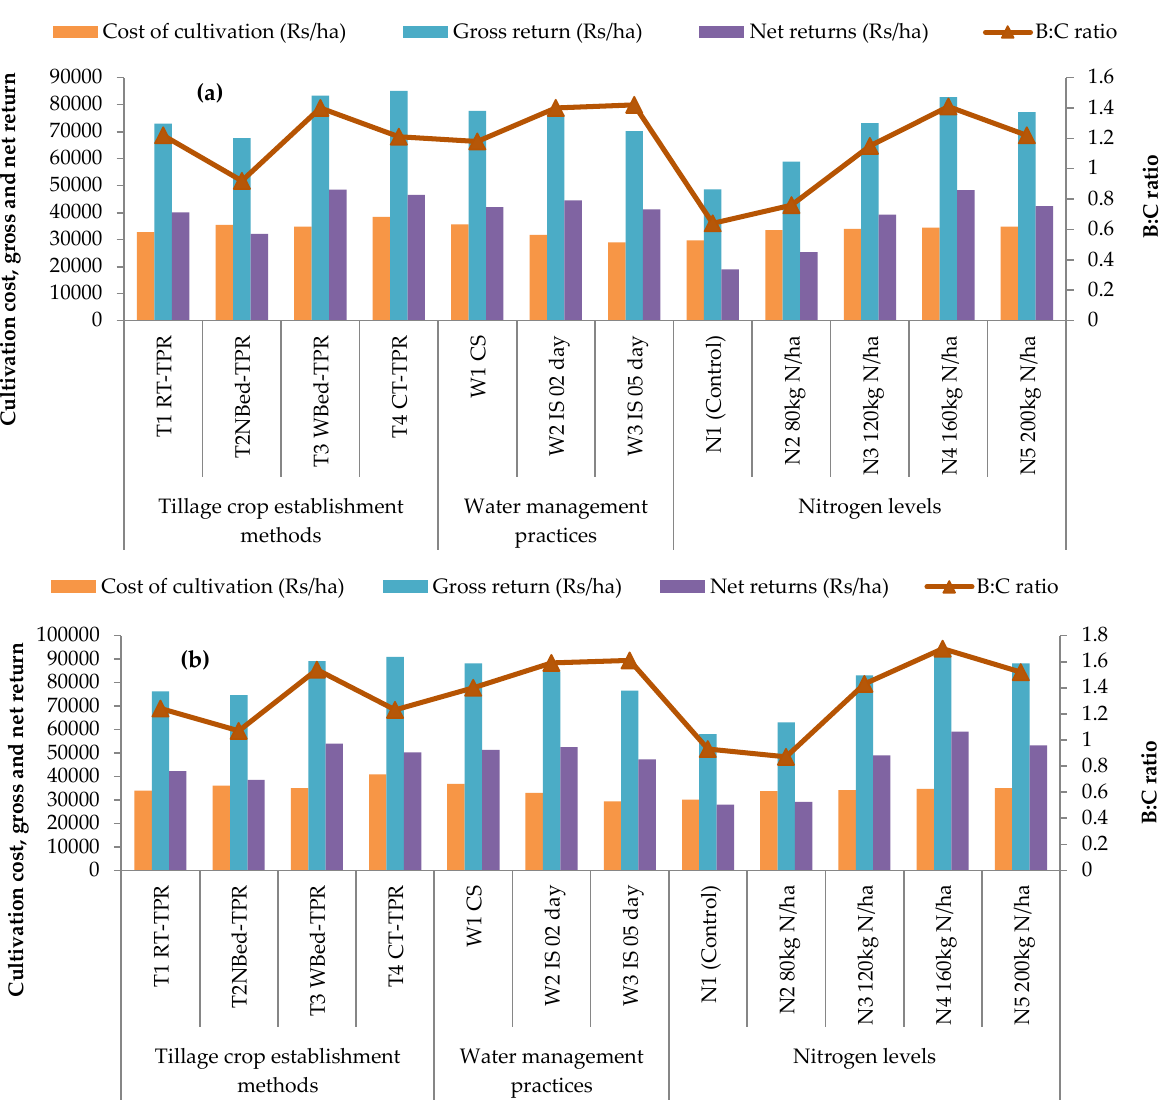
Figure 7. Interactive effects of tillage, water and nitrogen on the profitability of rice in both years: ( a ) 2016 and ( b ) 2017.